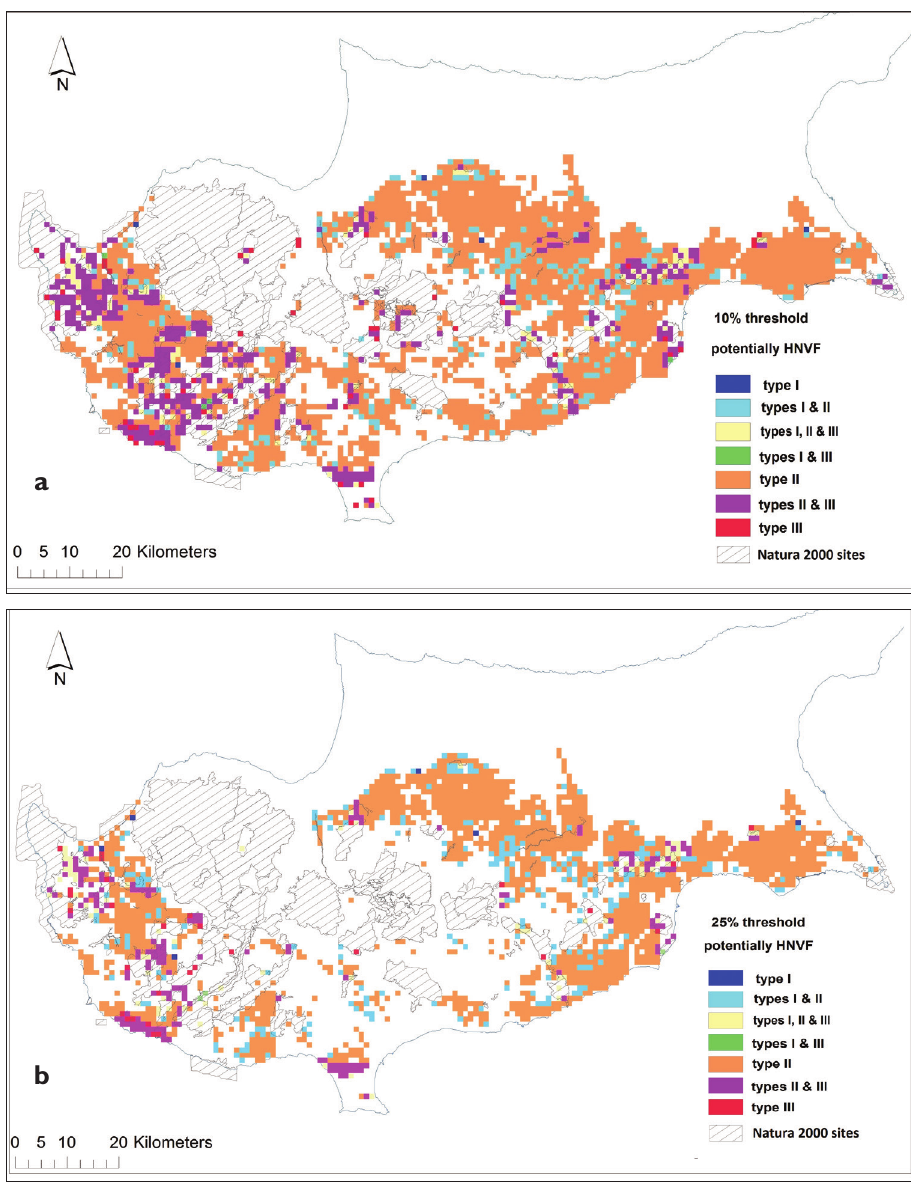
Figure 3. Potentially HNVf types according to a the 10% threshold and b the 25% threshold, in relation with existing Natura2000